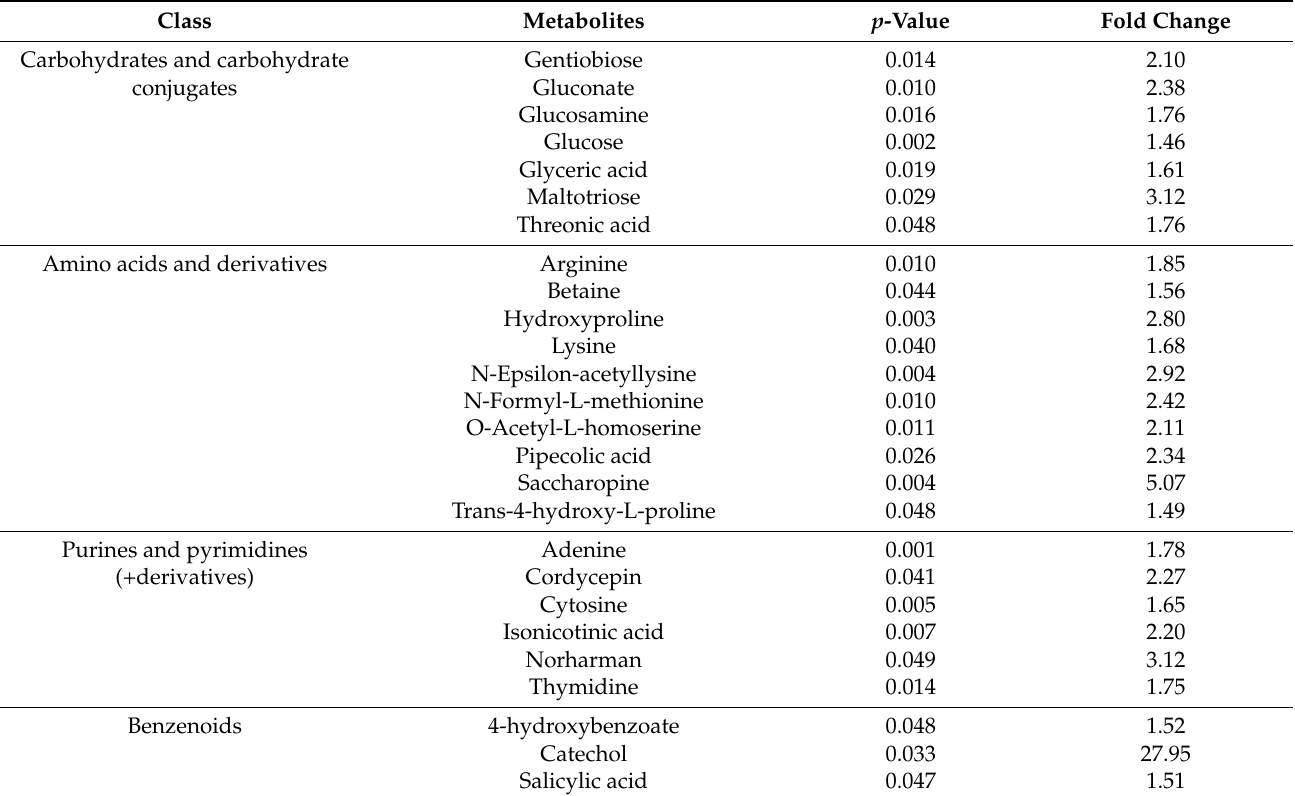
Table 2. Classification table of metabolites significantly changed in the carbofuran-treated